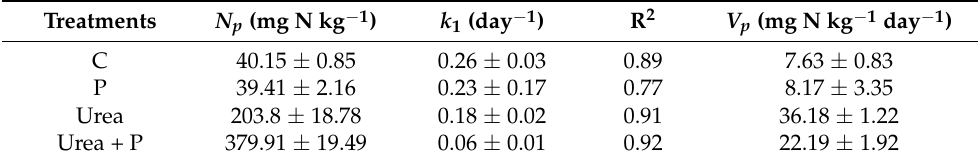
Table 2. Parameters of first-order kinetics model fitting soil NO 3 − -N accumulation during 10 days of